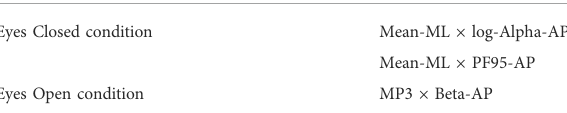
TABLE 4 Results of variable selection for Eyes closed and Eyes open conditions. The selected variables were the same for regression and classi fi cation. A detailed description of the postural features, including their descriptive statistics, is provided in Supplementary Material (see Section Computation of postural features and Supplementary Table